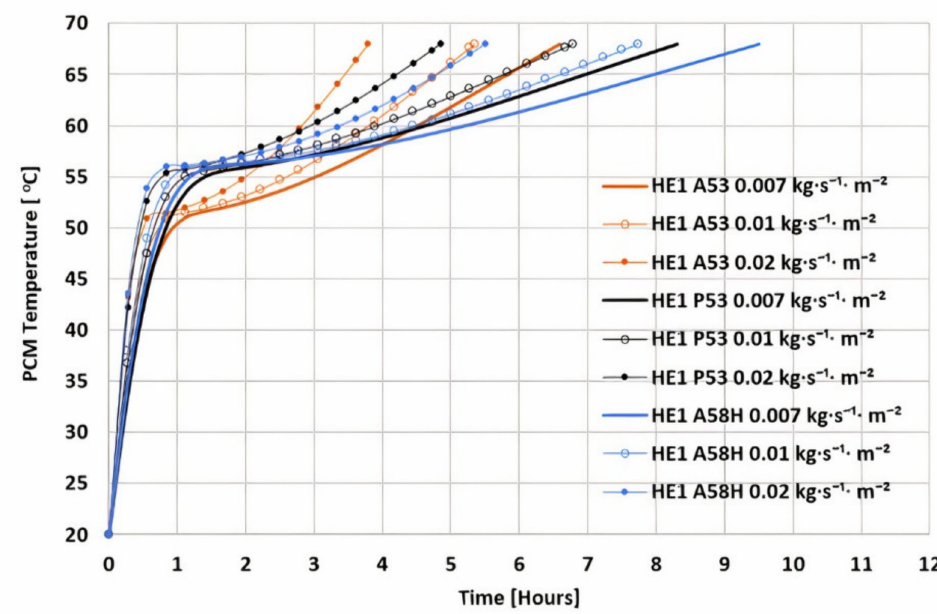
Figure 7. Area average temperature of PCM active volume during charging for all PCMs and all HTF flow rates studied, for HE1.